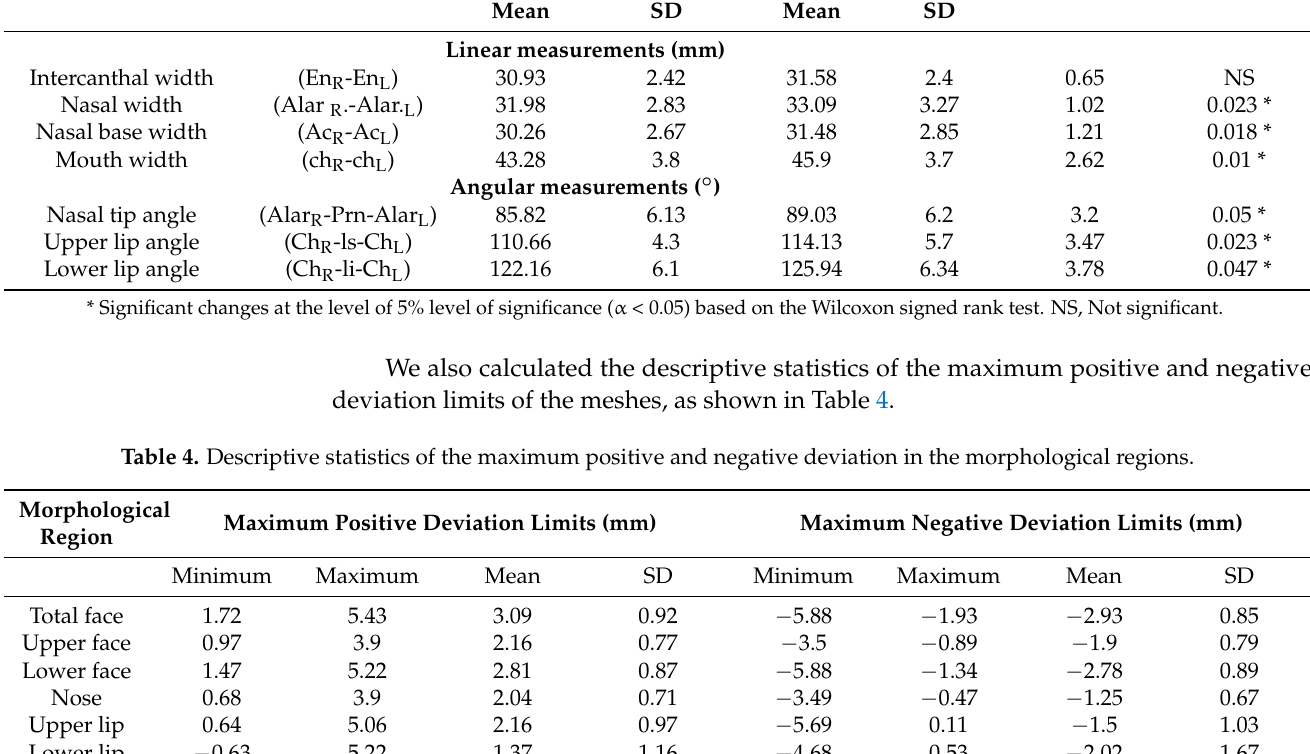
Table 3. Descriptive statistics of the pretreatment (T 0 ) and post-treatment (T 1 ) measurements. T 0